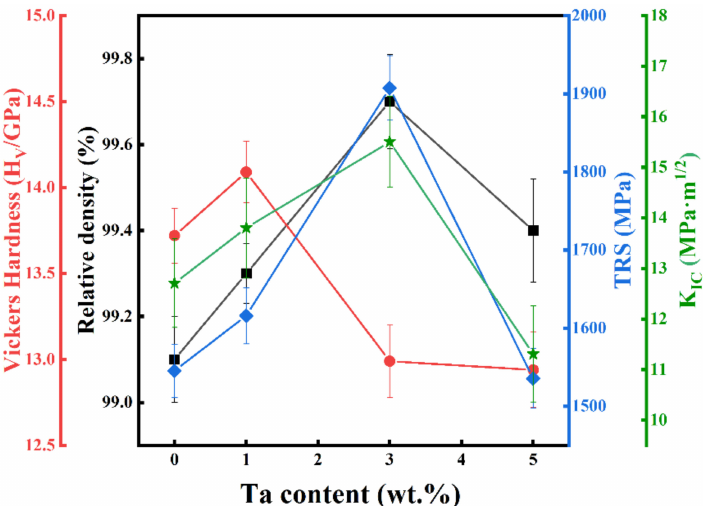
Figure 9. Effect of added Ta on the relative density and mechanical properties of the (Ti,W)C-xTa- based